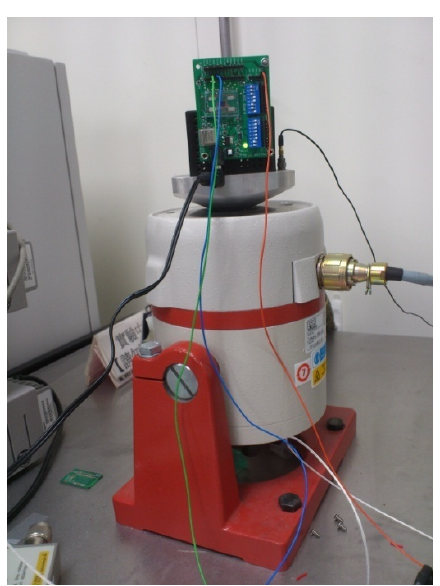
Figure 12. Measurement setup for accelerometer and readout circuit